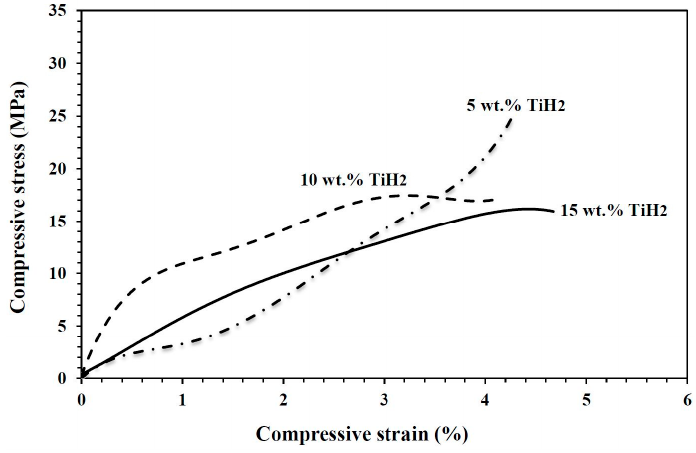
Figure 8. Compressive behavior of Ti matrix syntactic foam with SiC powder weight fraction of 0.5%.